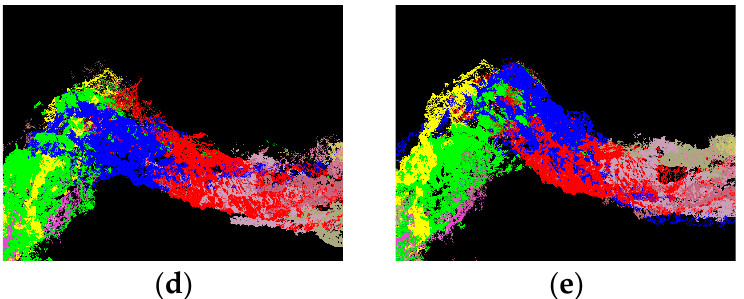
Figure 9. Local details of point cloud registration of Tangna karst cave, Bamei Town, Yunnan Prov-